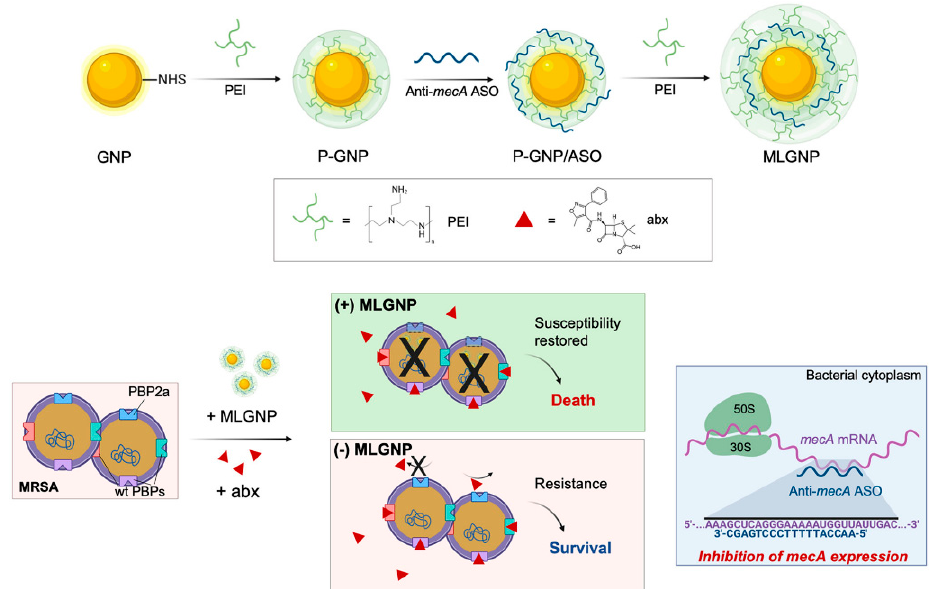
Figure 7. A schematic depiction of how to make ML-AuNPs that deliver antibiotic resistance-targeting ASOs and how to use them to treat MRSA infections in combination (reprinted with permission from [120]).